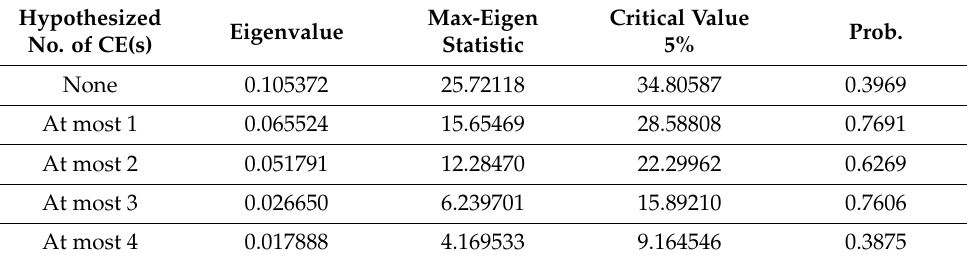
Table 9. Max eigenvalue—Johansen cointegration method (post-vaccine